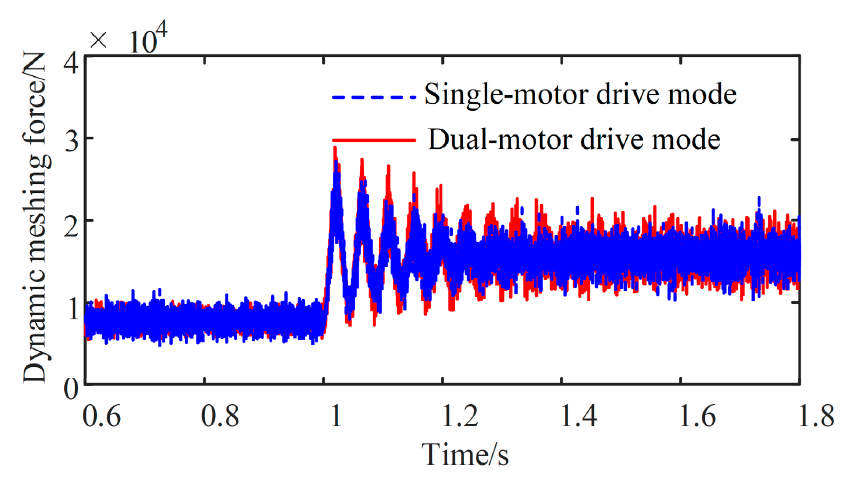
Figure 23. The meshing force of the third gear pair. To verify the conjecture that the speed synchronization error will lead to the deteri- oration of the torsional vibration of the gear system under impact conditions, the speed synchronization error of the two motors is changed by varying the speed loop parameter of the proportional integral (PI) controller in the motor controller to make the motor speed fluctuate to different degrees according to the method of [26], as shown in Figure 24. Differ- ent combinations of the PI controller parameters are set as follows: case 1: P = 0.1, I = 80; case 2: P = 0.5, I = 80; case 3: P = 1, I = 80.